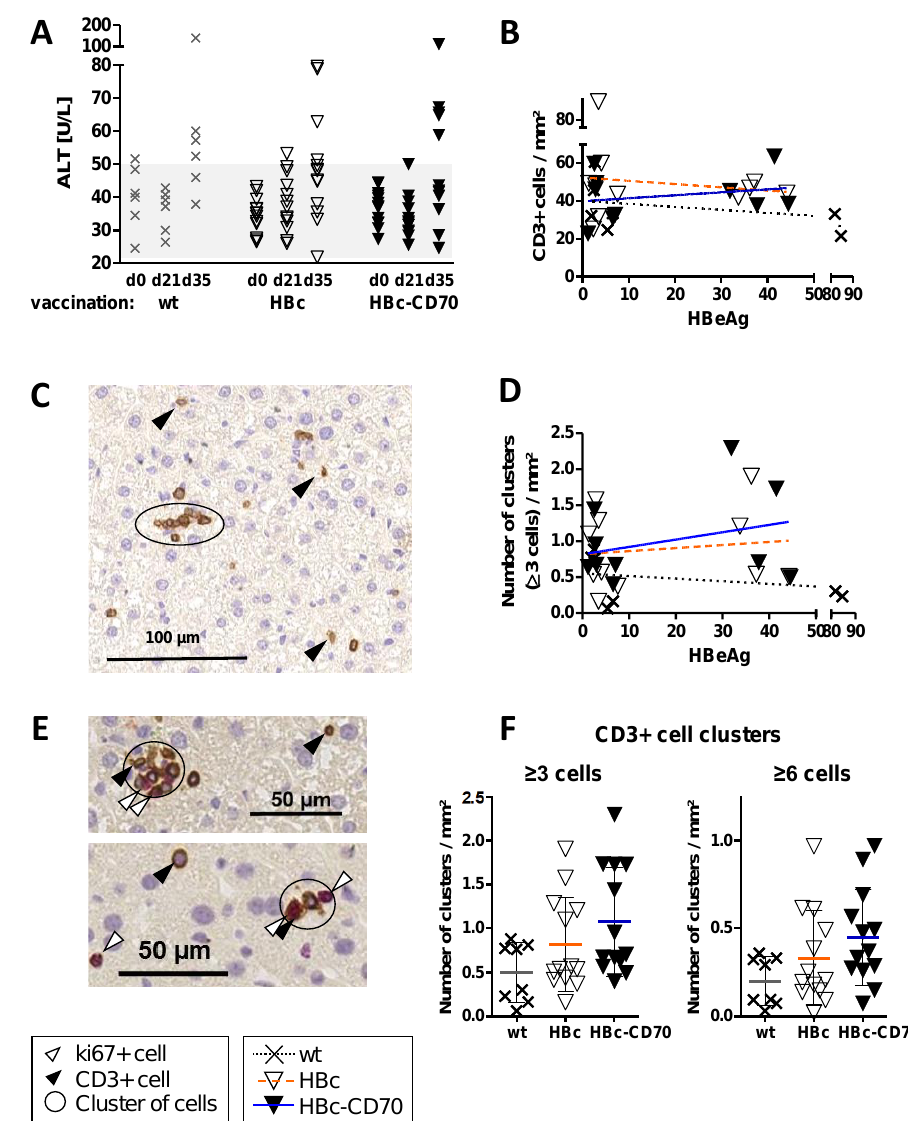
Figure 5. Serum alanine transaminase (ALT) levels and T cell infiltration into livers of HBV1.3tg mice after therapeutic vaccination with rMVA-HBc ± CD70. HBV1.3tg mice were immunized subcutaneously with 30 µ g of HBcAg adjuvanted with 32 µ g CpG and 25 µ g PCEP at day 0. At intraperitoneal injection. A control group received adjuvants only without the addition of protein and